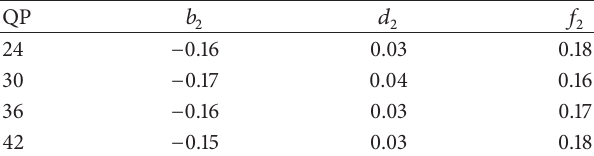
Table 4: Values of 𝑏 2 , 𝑑 2 , and 𝑓 2 for each video sequence.